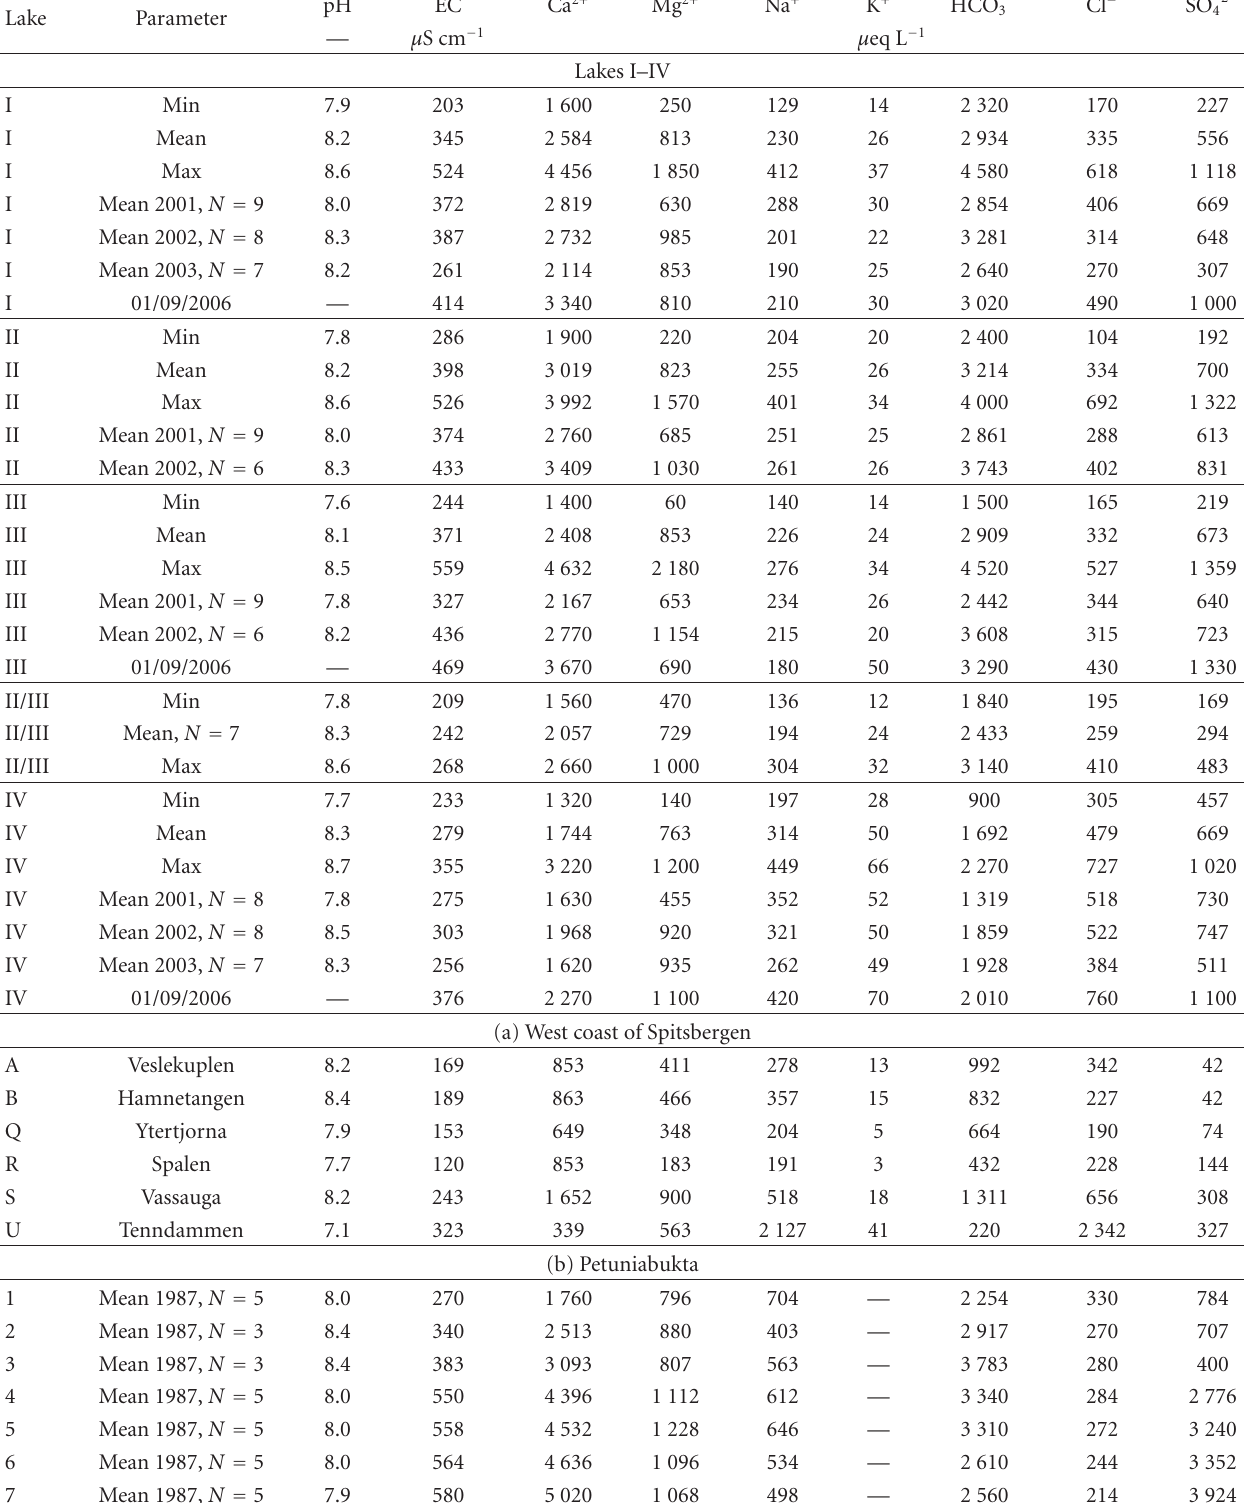
Table 2: Statistics for major ions, pH, and specific electric conductivity (EC) data for tundra lakes I–IV for the period 2001 to 2003 and separately for the years 2001, 2002, and 2003; also provided for comparison are the chemical properties of water in Lakes I, III, and IV on 1 September 2006 and (a) in the lakes on the strandflat of Spitsbergen between 28th July and 14th August 1995 [12] as well as (b) in the